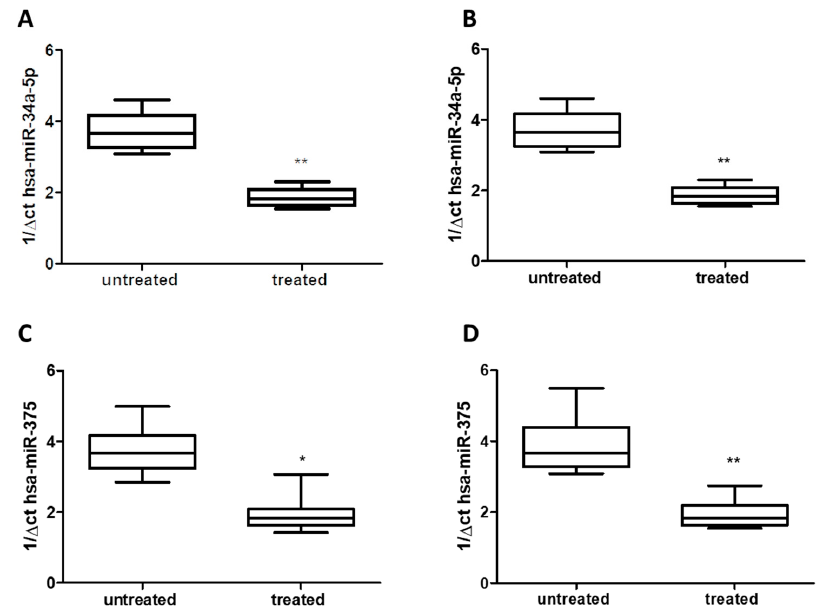
Figure 2. Expression of miRs in serum: ( A ) hsa-miR-34a-5p; ( C ) hsa-miR-375, and saliva: ( B ) hsa-miR-34a-5p, ( D ) hsa-miR-375: of either treated and untreated subjects with migraine. miRs data are plotted as box and whiskers 10:90 percentiles. * p < 0.05; ** p < 0.01.